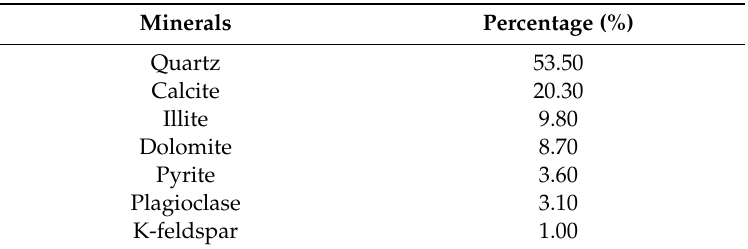
Table 2. Mineral compositions of the Longmaxi shale.